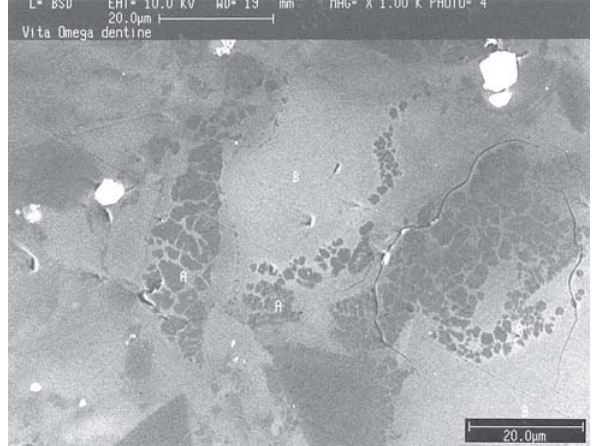
FIGURE 1- Photomicrograph of Vita Omega dentine ceramic (Vita Zahnfabrik, Bad Sackingen, Germany), a leucite based feldspathic ceramic. BSI of the microstructure showing (A) clusters of leucite in the glass matrix (B). Cracks can be observed around the leucite clusters; bright particles are ) 17 zirconia (ZrO 2